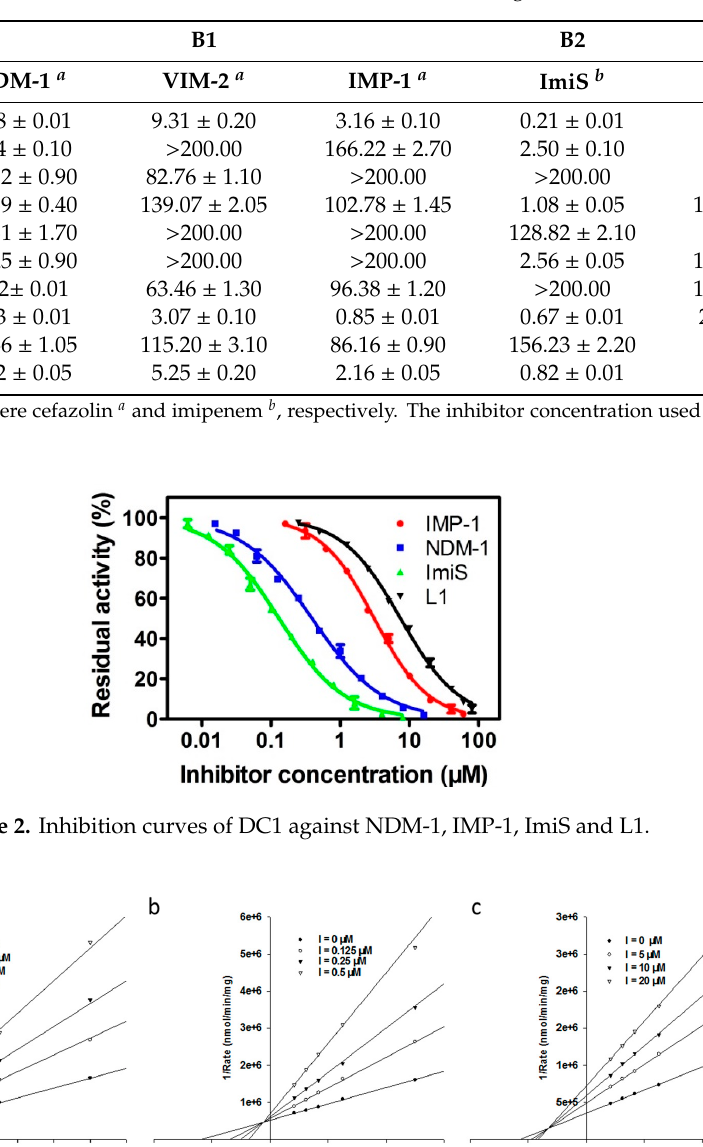
Figure 3. Lineweaver–Burk plots with NDM ‐ 1 ( a ), ImiS ( b ), and L1 ( c ) using cefazolin and